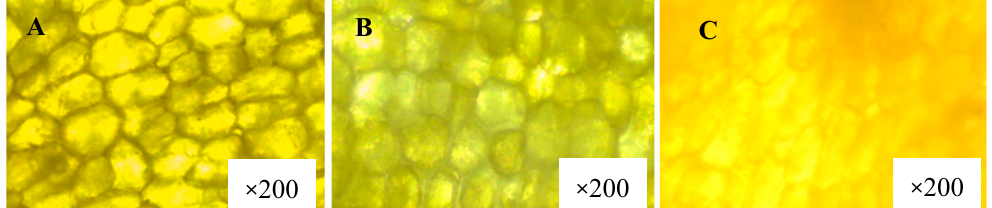
Figure 3. Morphology of lipid bodies in the mesocarp fiber of OPF (light micrograph of section through the mesocarp: A —untreated OPF, B —heat-treated OPF in water at 343 K for 60 min., and C —heat-treated OPF in water at 373 K for 60 min).